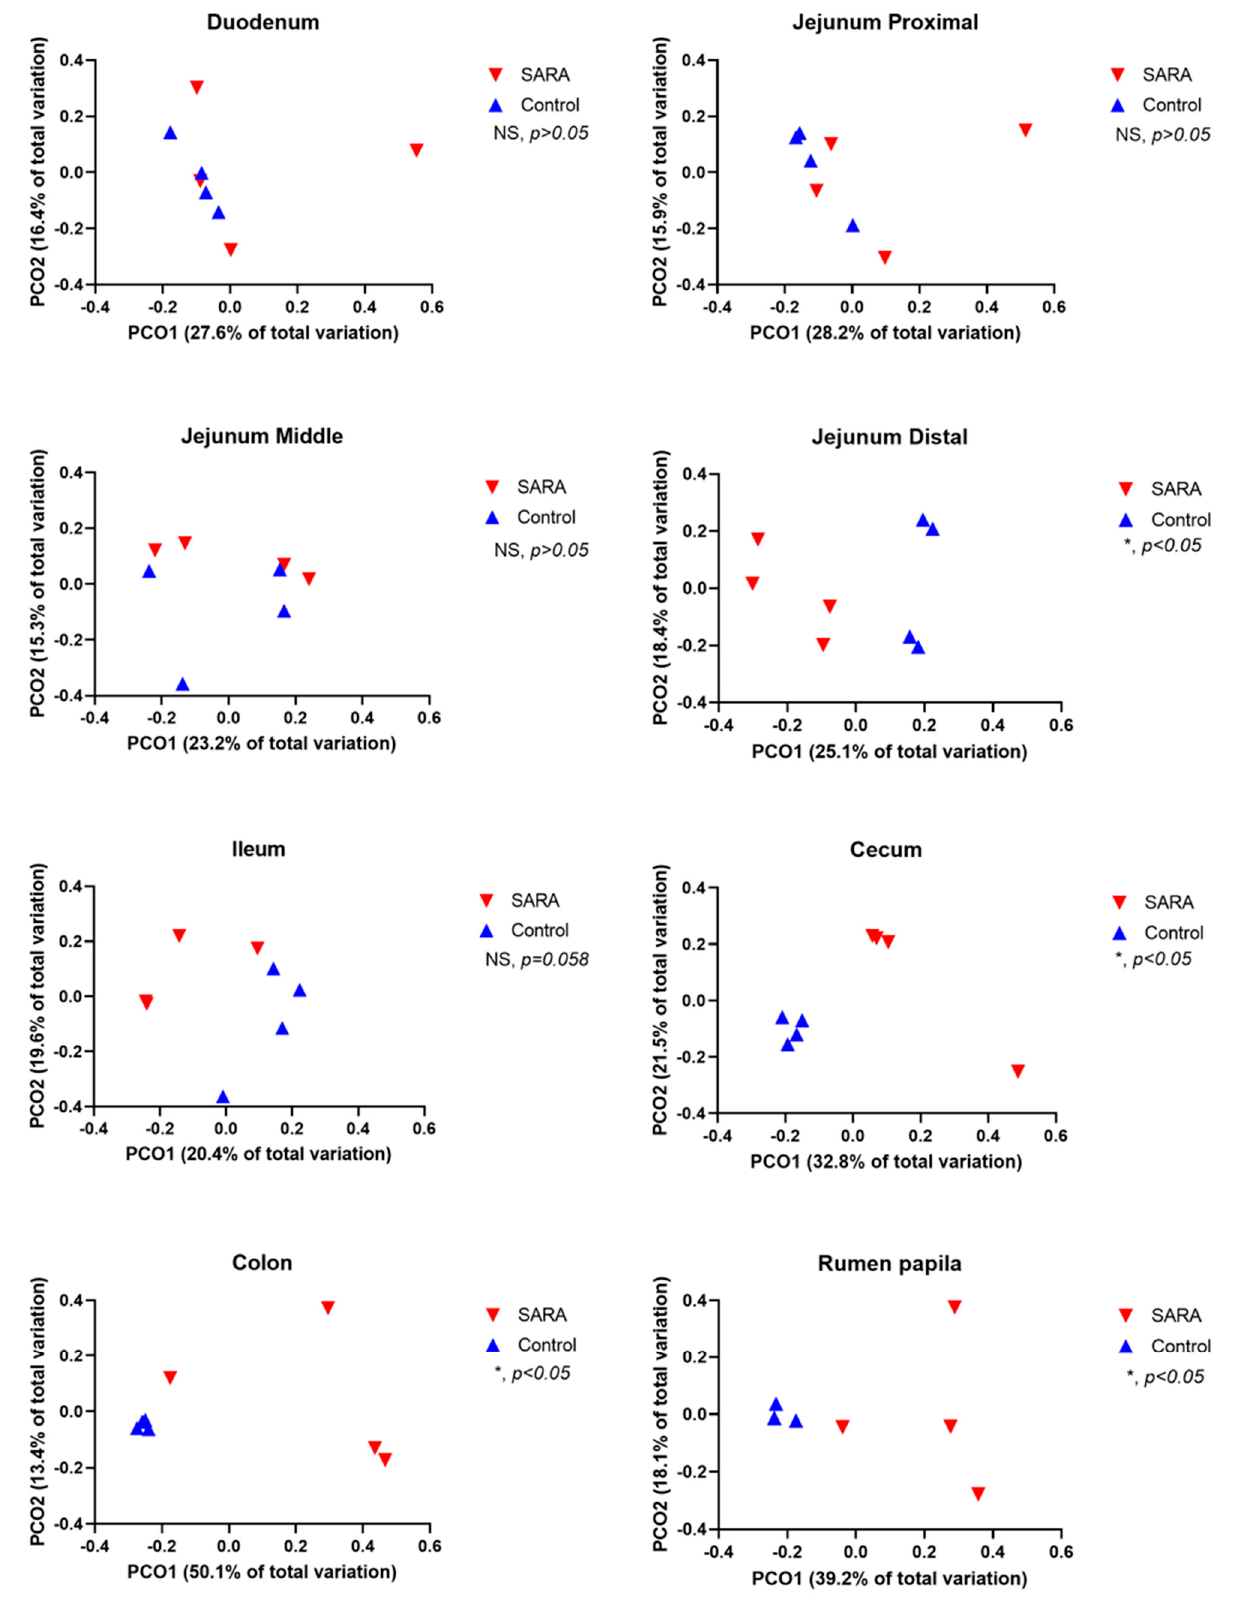
Figure 2. Principal coordinate analysis (PCoA) of weighted UniFrac distances of treatments (C = control, S = SARA) by site in the digestive tract.